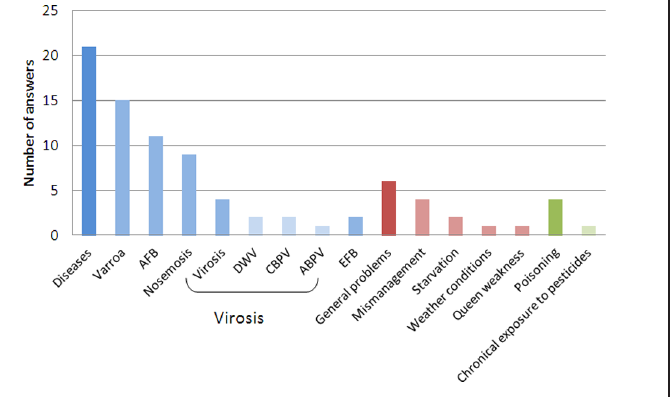
Figure 5. Main causes of colony mortality reported by the laboratories, in 2010. Diseases: non-specified diseases, AFB: Amer- ican foulbrood, SBV: sacbrood virus, CBPV: Chronic Bee Paralysis Virus, DWV: Deformed Wing Virus, EFB: European foulbrood.